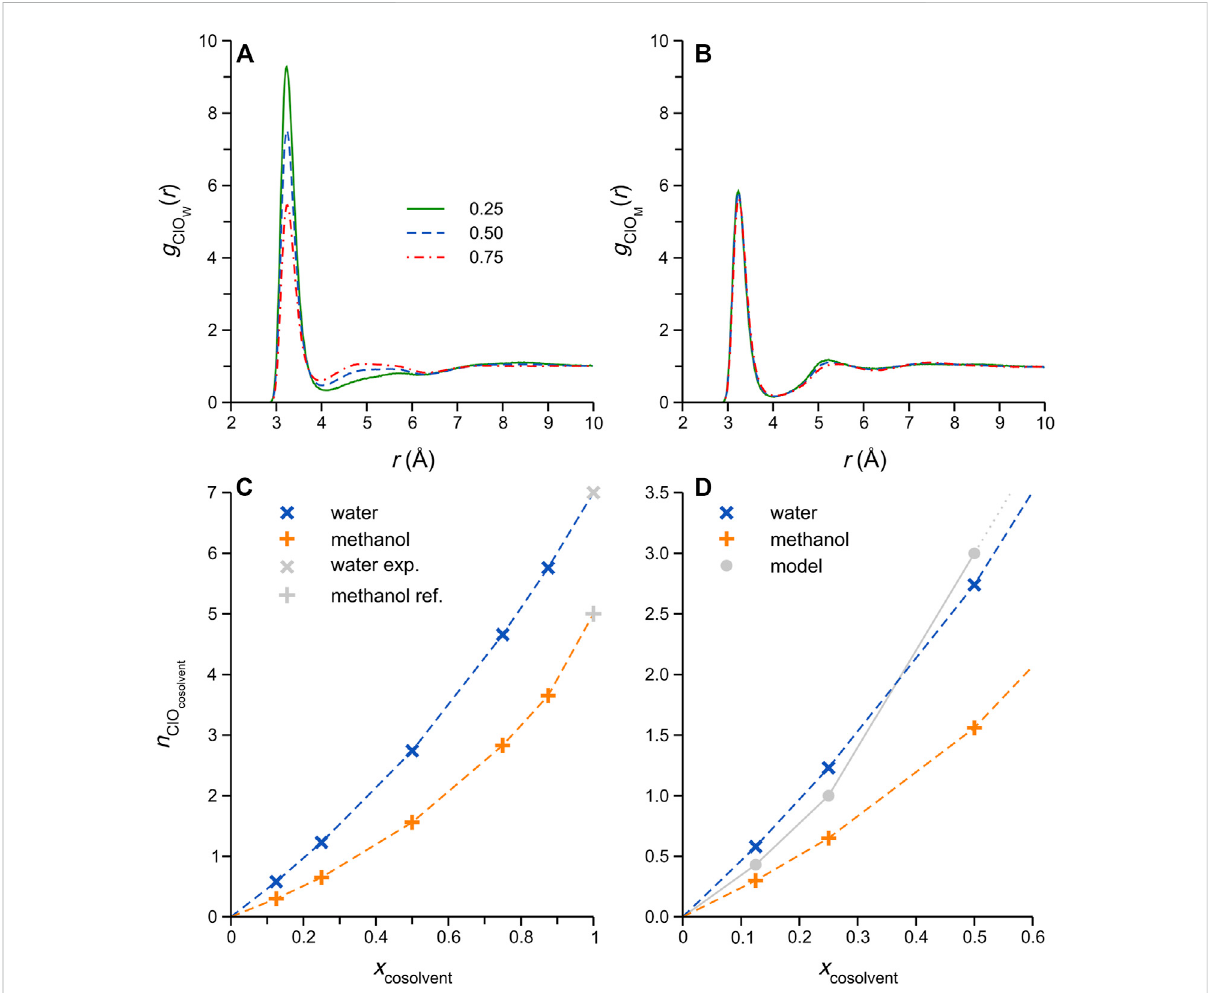
FIGURE 4 Cl − -O cosolvent RDFs for selected (A) DES/water, and (B) DES/methanol simulated mixtures; the legend in panel A refers to the cosolvent mole fraction,andappliestoboth (A,B) . (C) Cl − -O cosolvent coordinationnumbers,computedbyintegrationofcorresponding g ClO ( r ) fi rstmaxima,plottedas a function of cosolvent content. The Cl − coordination number in the respective cosolvents (i.e. effectively in fi nite dilution) was taken from literature sources:Powelletal. (Powelletal.,1993)for thecoordination numberinwater,andImpey etal. (Impey etal.,1987)formethanol. (D) Expansion of the low x cosolvent range in (C) , showing the expected Cl − -cosolvent coordination number variation considering a simple strong Cl − -cosolvent attraction model (grey circles connected by solid grey line) described in the main